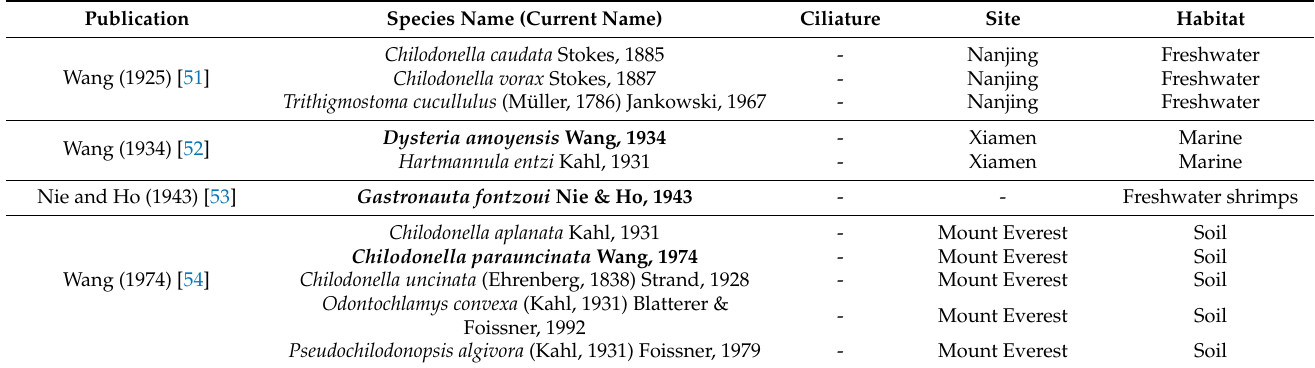
Table 1. Checklist of cyrtophorian ciliate species/isolates with morphological descriptions from China. New species are highlighted in bold. Species are presented with current names. * Ref. [4] by Song et al. summarizes 32 species found by Song’s group (Ocean University of China) from 1991 to 2008. Here, only seven species/populations not published before 2009 are listed. † This species was isolated from marine water, which is different from those populations of Chilodonella uncinata isolated from soil or freshwater habitats; thus, we count it as a different species. § Previous name was Chilodonella parauncinata